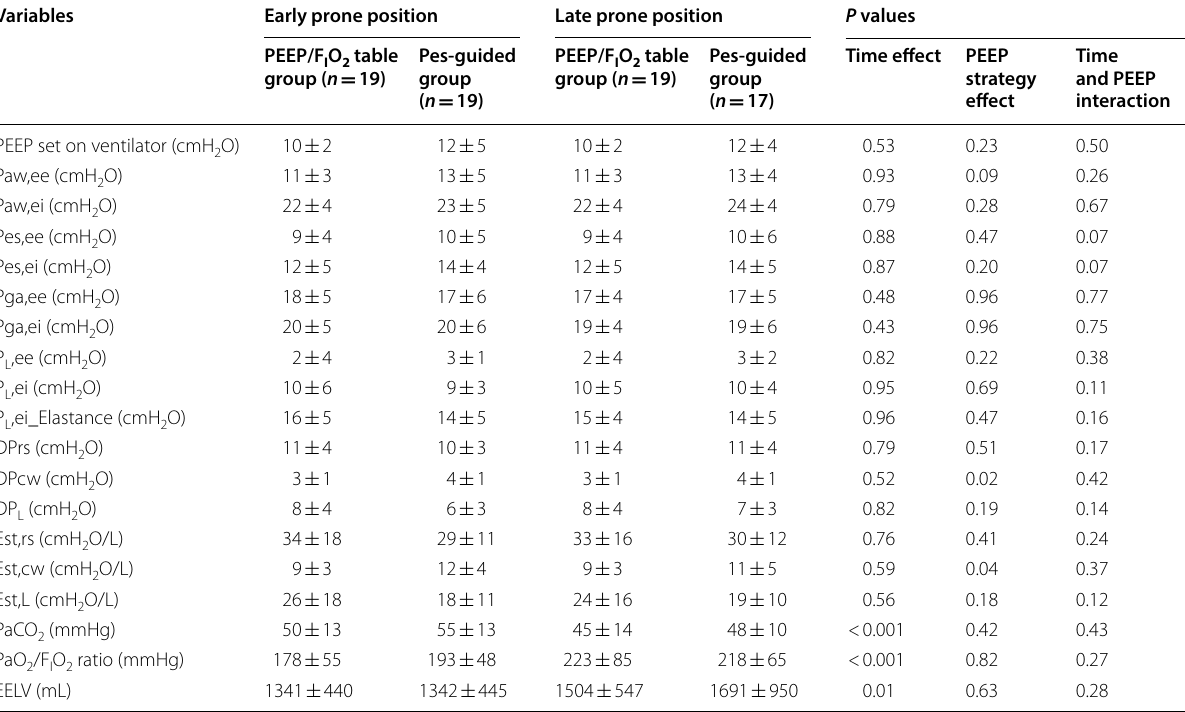
Values are mean